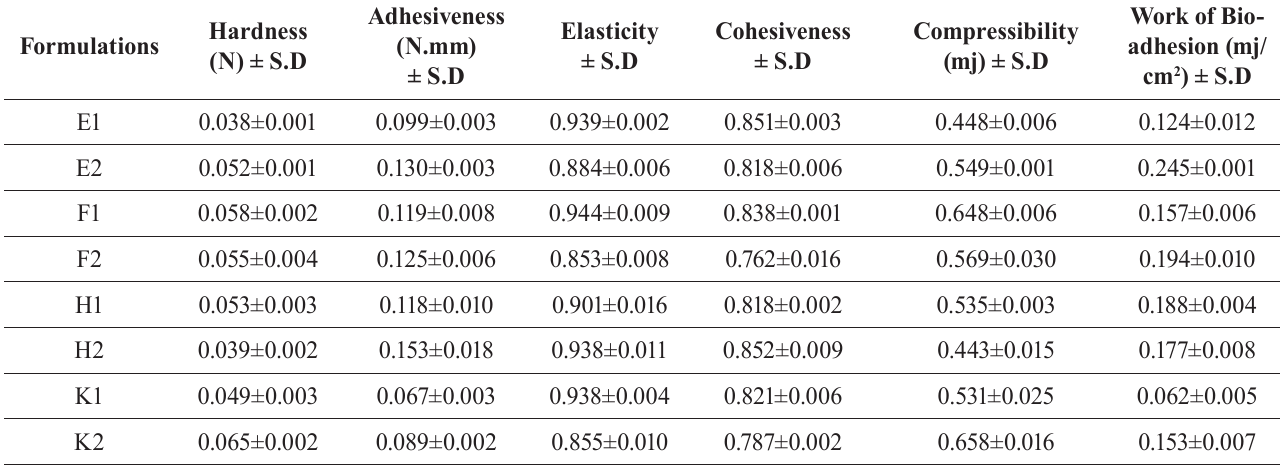
TABLE III - Mechanical and bioadhesive properties of hydrogel formulations (n=3). The mechanical and bioadhesive characterizations of hydrogels were measured when the hydrogels reached room temperature